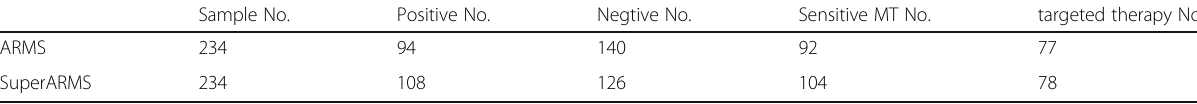
Table 4 EGFR Mutation Status and TKIs treatment Sample No. Positive No. Negtive No. Sensitive MT No. targeted therapy